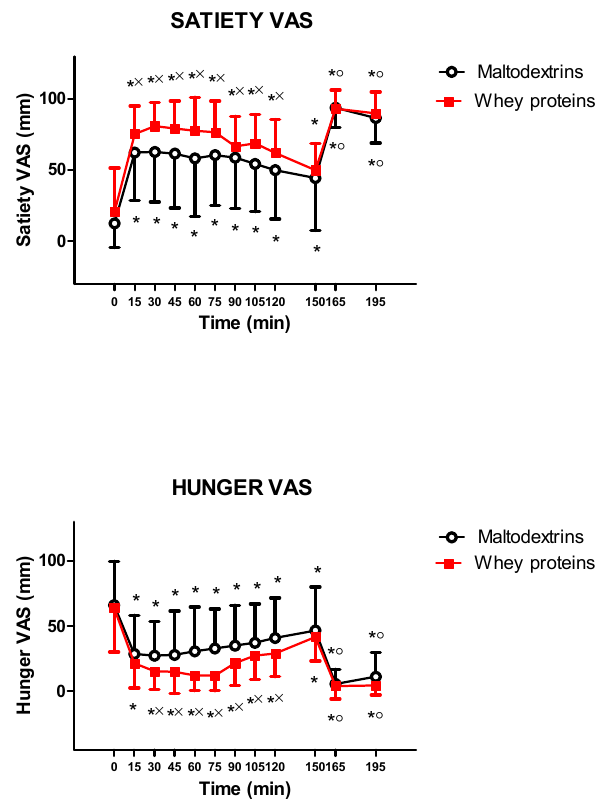
Figure 2. Changes of VAS (visual analogic scale) ratings of satiety ( top ) and hunger ( bottom ) in young obese subjects after the intake of a drink (completely within 15 min starting at T0), containing whey proteins or maltodextrins. At T150, a mixed lunch was offered and was completely consumed within 15 min. See the text for further details. Values are expressed as mean ± SD. The number of subjects was 9. * p < 0.05 vs. the corresponding T0 value; × p < 0.05 vs. the corresponding value of the maltodextrins-treated group; and ○ p < 0.05 vs. the corresponding T150 value. A two-way ANOVA with repeated measures (with the two factors time and group and the interaction time × group), followed by the post hoc Tukey’s test, was used.